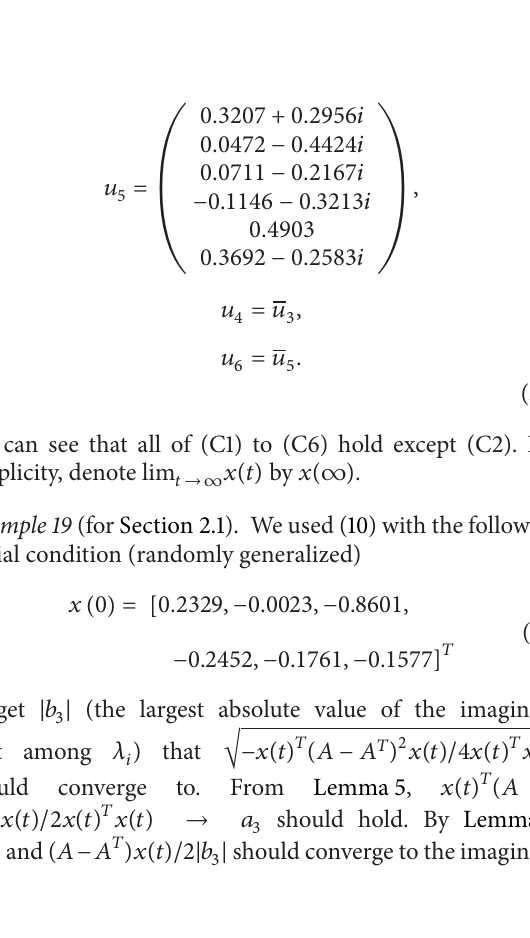
Figure 3: The schematic diagram of the neural network equation (2) for solving the eigenvector corresponding to the modulus largest eigenvalues of real symmetric matrix 𝐴